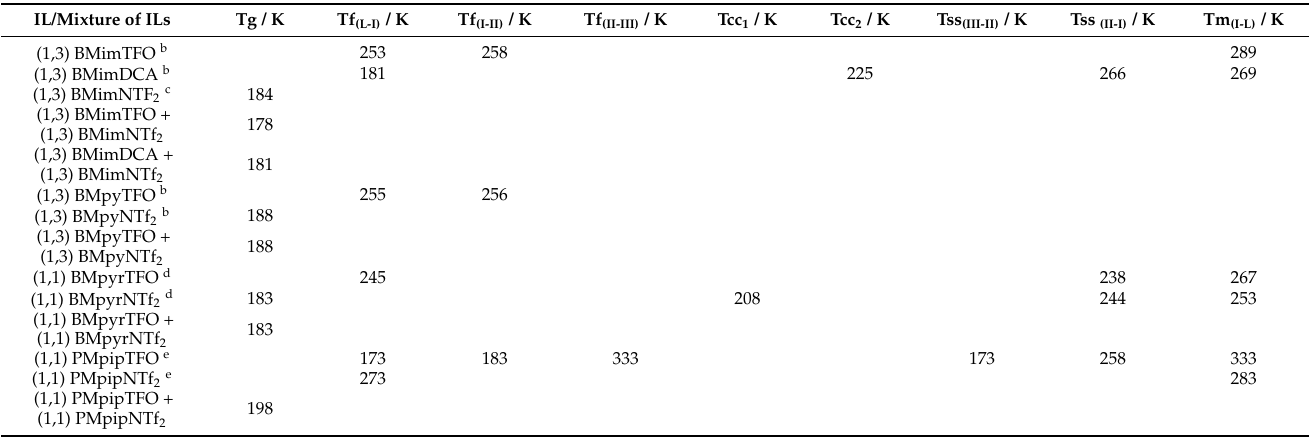
Table 3. Results of the thermal analysis for the pure ILs [10–12] and their mixtures a .